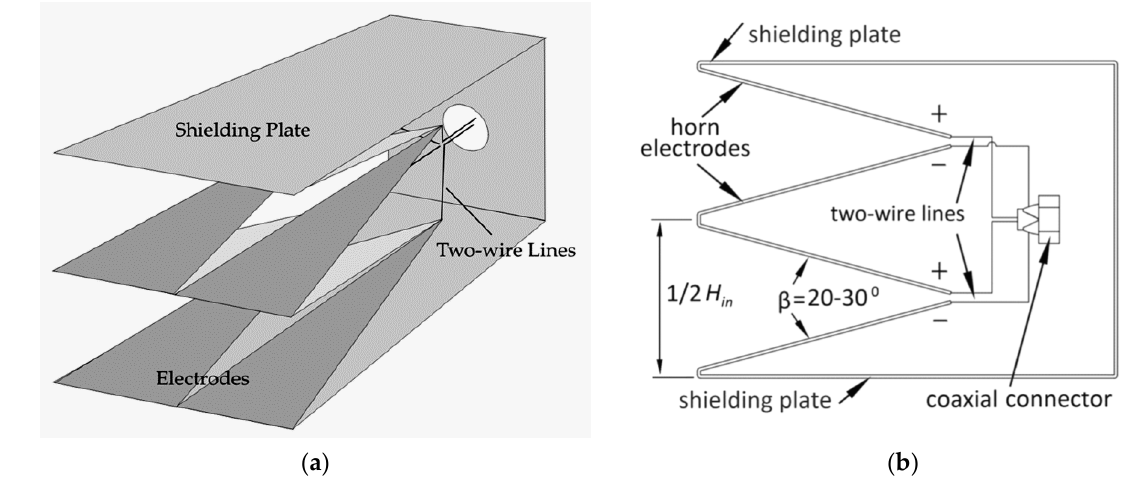
Figure 1. General design of the S ‐ TEM ‐ horn antenna array. ( a ) 3D design. ( b ) 2D design and schematic linking of the antenna elements.